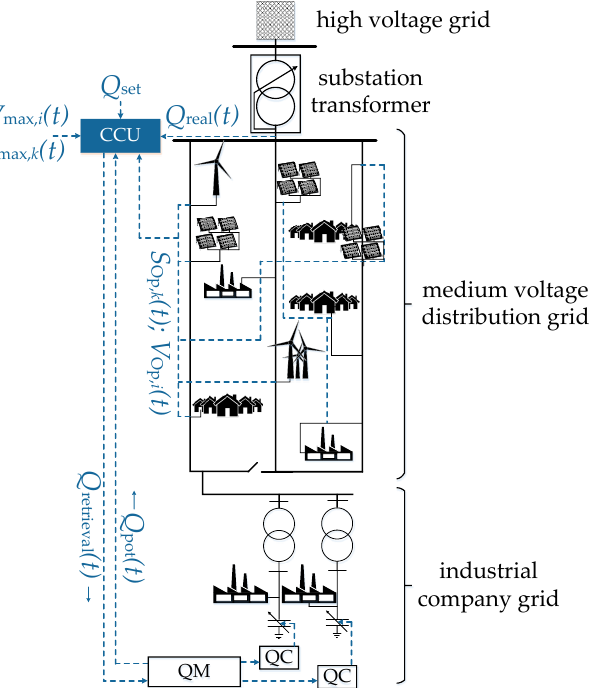
Figure 6. Schematic illustration of the central reactive power control strategy in an exemplary medium-voltage grid with an industrial company with two ICS as reactive power sources.